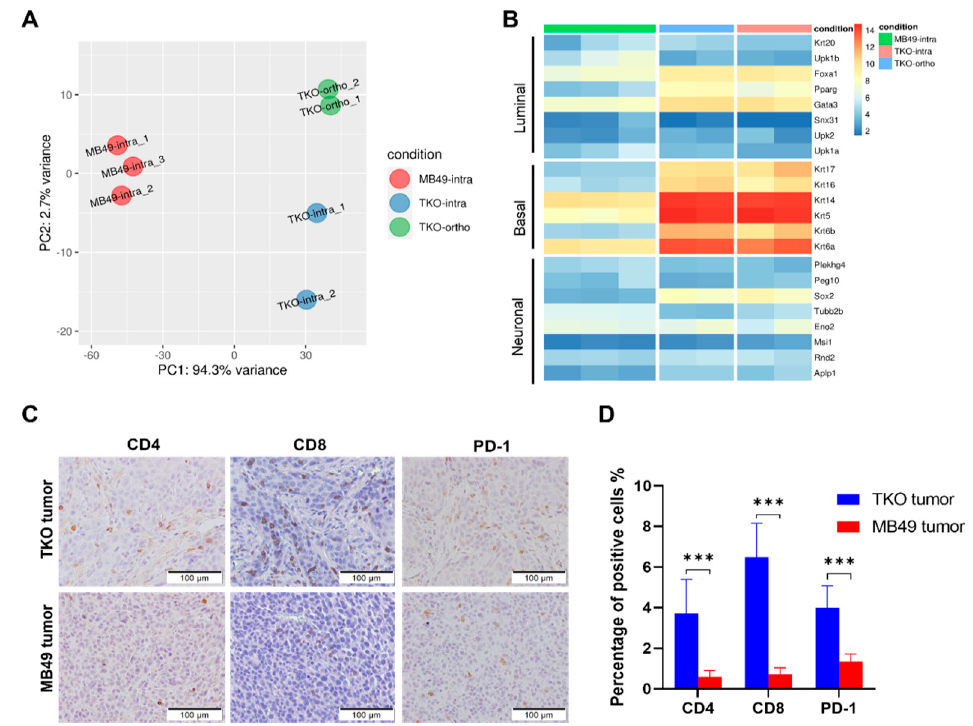
Figure 3. The molecular and immune characterization of TKO tumors. ( A ) The inter-and intra-group variability of the TKO tumors was illustrated by the principal component analysis (PCA) of the RNA- seq data. Each dot represents a tumor: TKO intravesical tumors (TKO-intra, blue), TKO orthotopic tumors (TKO-ortho, green), and MB49 intravesical tumors (MB49-intra, red). ( B ) Clustering heatmap of TKO intravesical tumors (pink), TKO orthotopic tumors (blue), and MB49 intravesical tumors (green) using the luminal/basal/neuronal classifier. ( C ) Representative IHC staining of CD4, CD8, and PD-1 in subcutaneous tumor tissues. ( D ) The quantification of CD4, CD8, and PD-1 positive cells in subcutaneous tumor sections stained by IHC. p -value, ANOVA with Tukey’s multiple comparisons test, p < 0.001